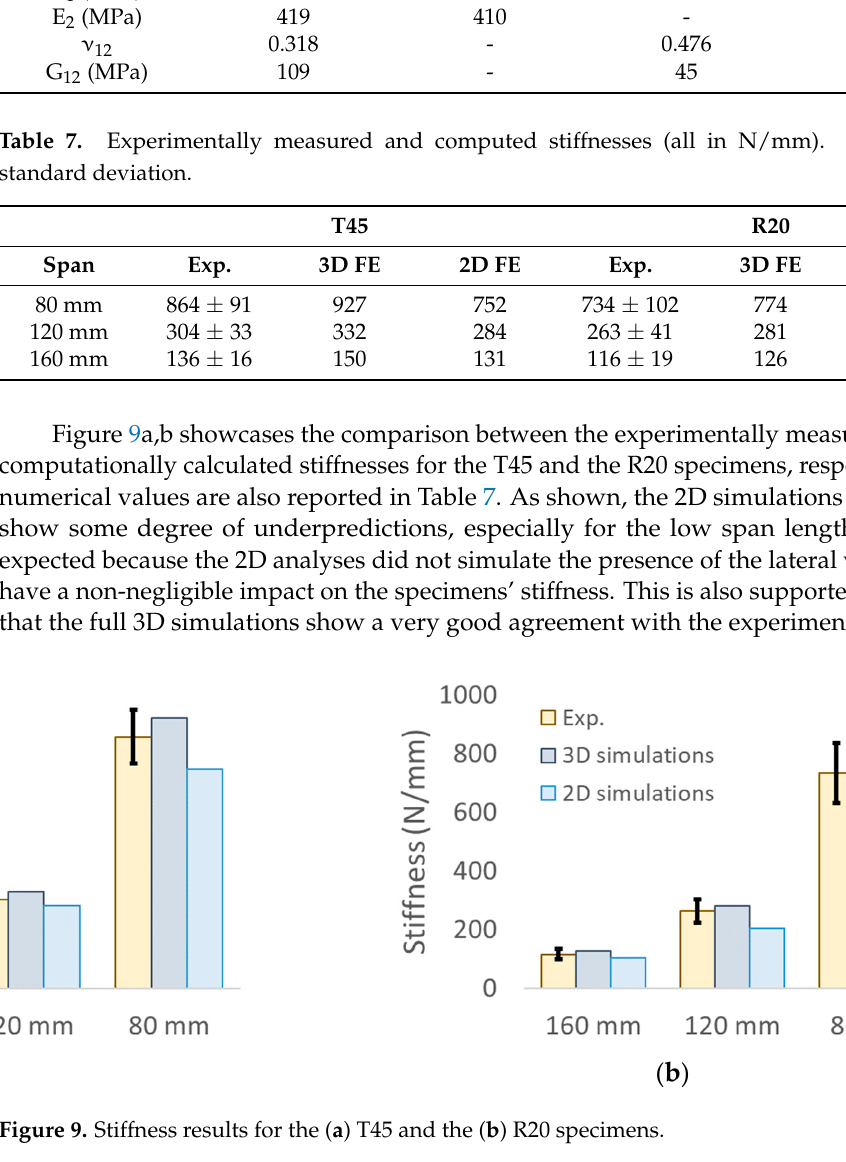
Figure 8. Model of the reference component.